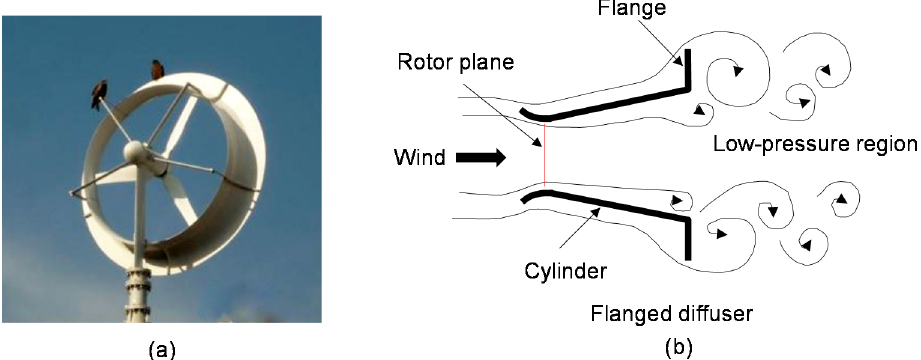
Figure 1. ( a ) A 3 kW wind turbine shrouded by a flanged diffuser and ( b ) illustration of wind flow around the flanged diffuser